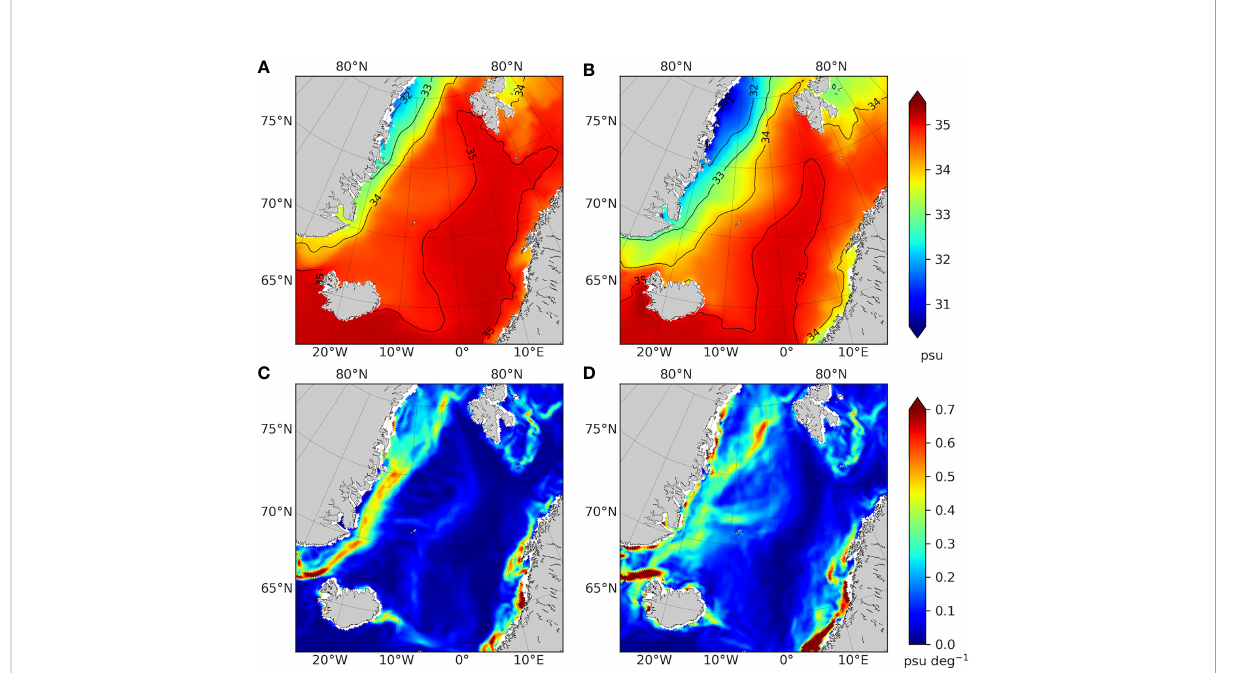
FIGURE 4 Spatial distribution of climatological near-surface salinity and its gradient magnitude of TOPAZ4 data in (A) , (C) March and (B) , (D)